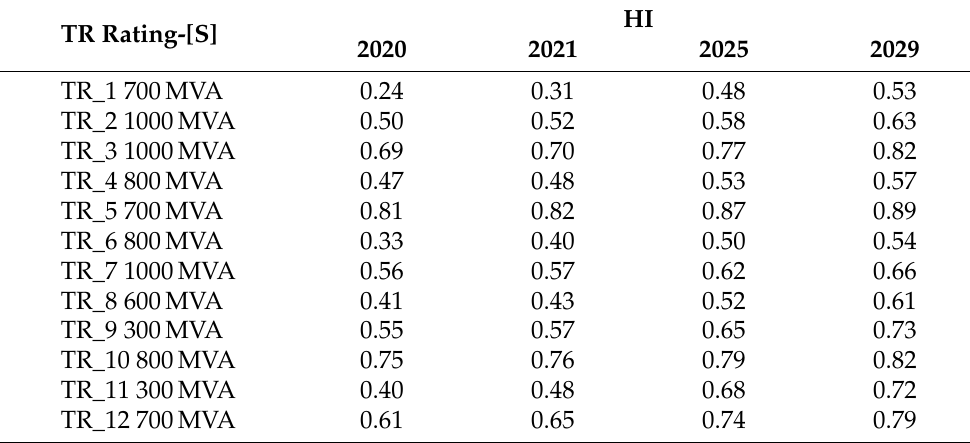
Table 2. Condition assessment forecast using health index.